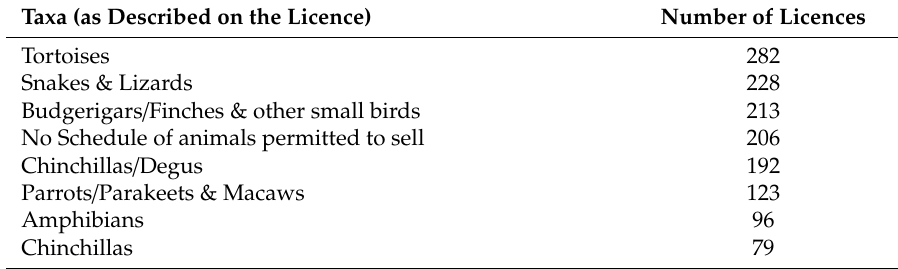
Table A2. Descriptions of taxa permitted for sale in 2019 as listed across all licences, and number